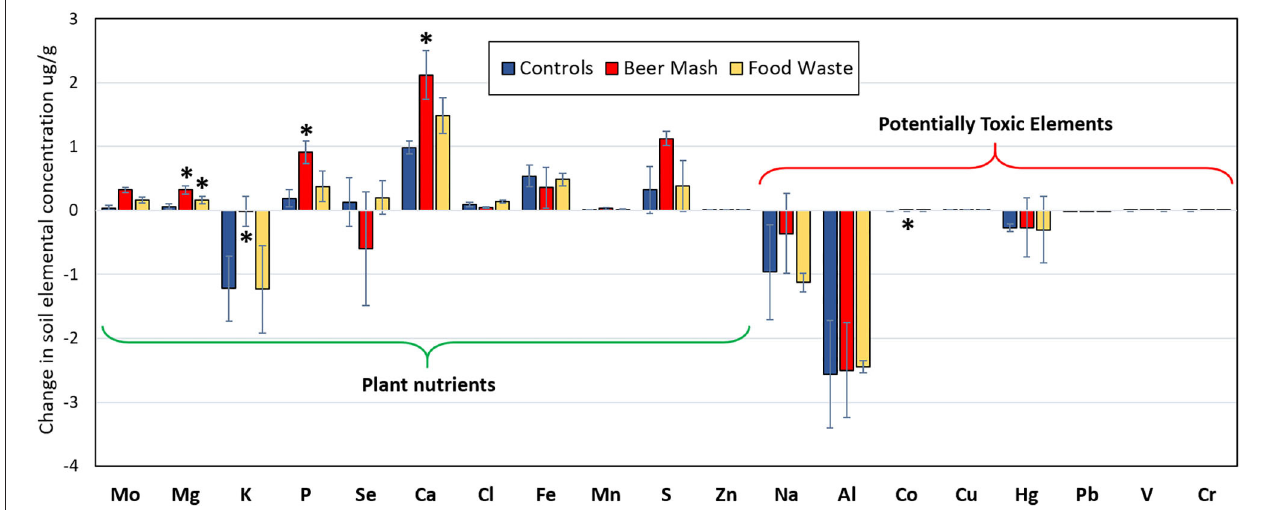
FIGURE 9 | Elemental composition changes ( µ g/g) between week 1 and 10 in potting soil samples from different treatments as detected by X-ray fluorescence spectrometer. Treatment consisted of nutrient solution not amended (Control) in blue, or amended with Beer mash (BM) in red, food waste (FW) in yellow. Plant nutrient elements tested included: molybdenum (Mo), magnesium (Mg), potassium (K), phosphorus (P), selenium (Se), calcium (Ca), chlorine (Cl), iron (Fe), manganese (Mn), sulfur (S), zinc (Zn); Potentially toxic elements tested included: sodium (Na), aluminum (Al), cobalt (Co), copper (Cu), mercury (Hg), lead (Pb), vanadium (V), and chromium (Cr). Arsenic (As) and cadmium (Cd) concentrations were considered too low to include. Error bars represent standard deviations of the mean ( n = 3) where variation was great enough to be presented. For each element, significant differences observed by ANOVA tests (at P = 0.05) followed by multiple comparisons vs. control group procedures (Holm-Sidak method) are indicated with asterisks